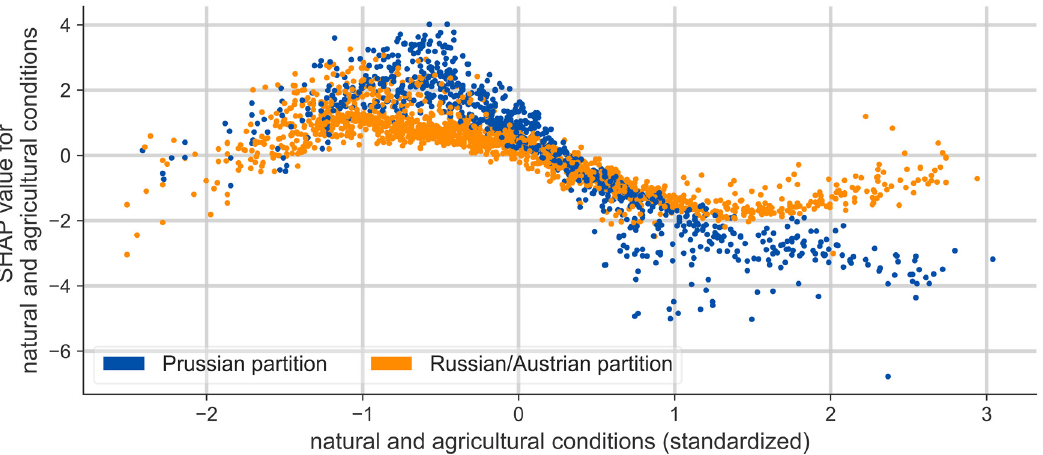
Figure 7. Shapley values for the variable presenting the quality of production environment in agriculture. Source: developed by the authors, based on ARMA and CSO data.